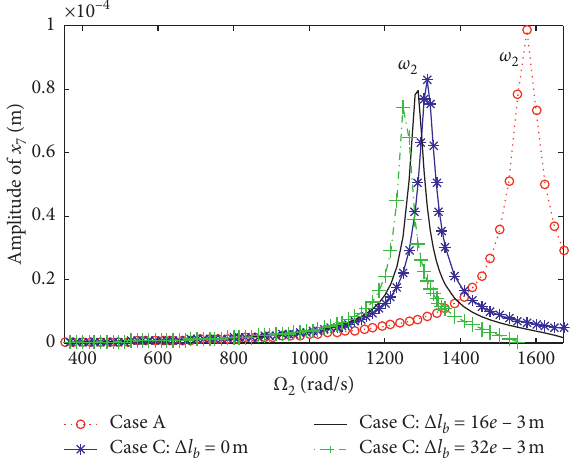
Figure 6: Vibration amplitudes of node 7 versus rotation speeds for different Δ l